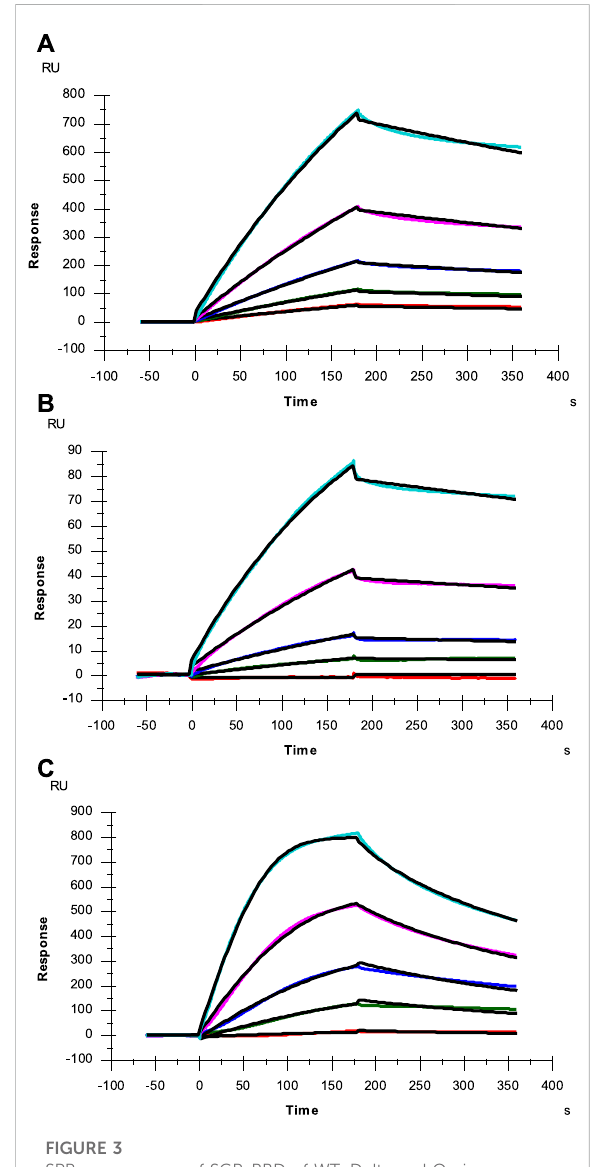
FIGURE 3 SPR sensorgrams of SGP-RBD of WT, Delta and Omicron variants interaction with heparin. Concentration of SGP-RBD mutants (from top to bottom): 1000, 500, 250, 125, and 63 nM, respectively. The black curves are the fi tting curves using models from Biacore T200 Evaluation software (A) WT; (B) Delta; (C)